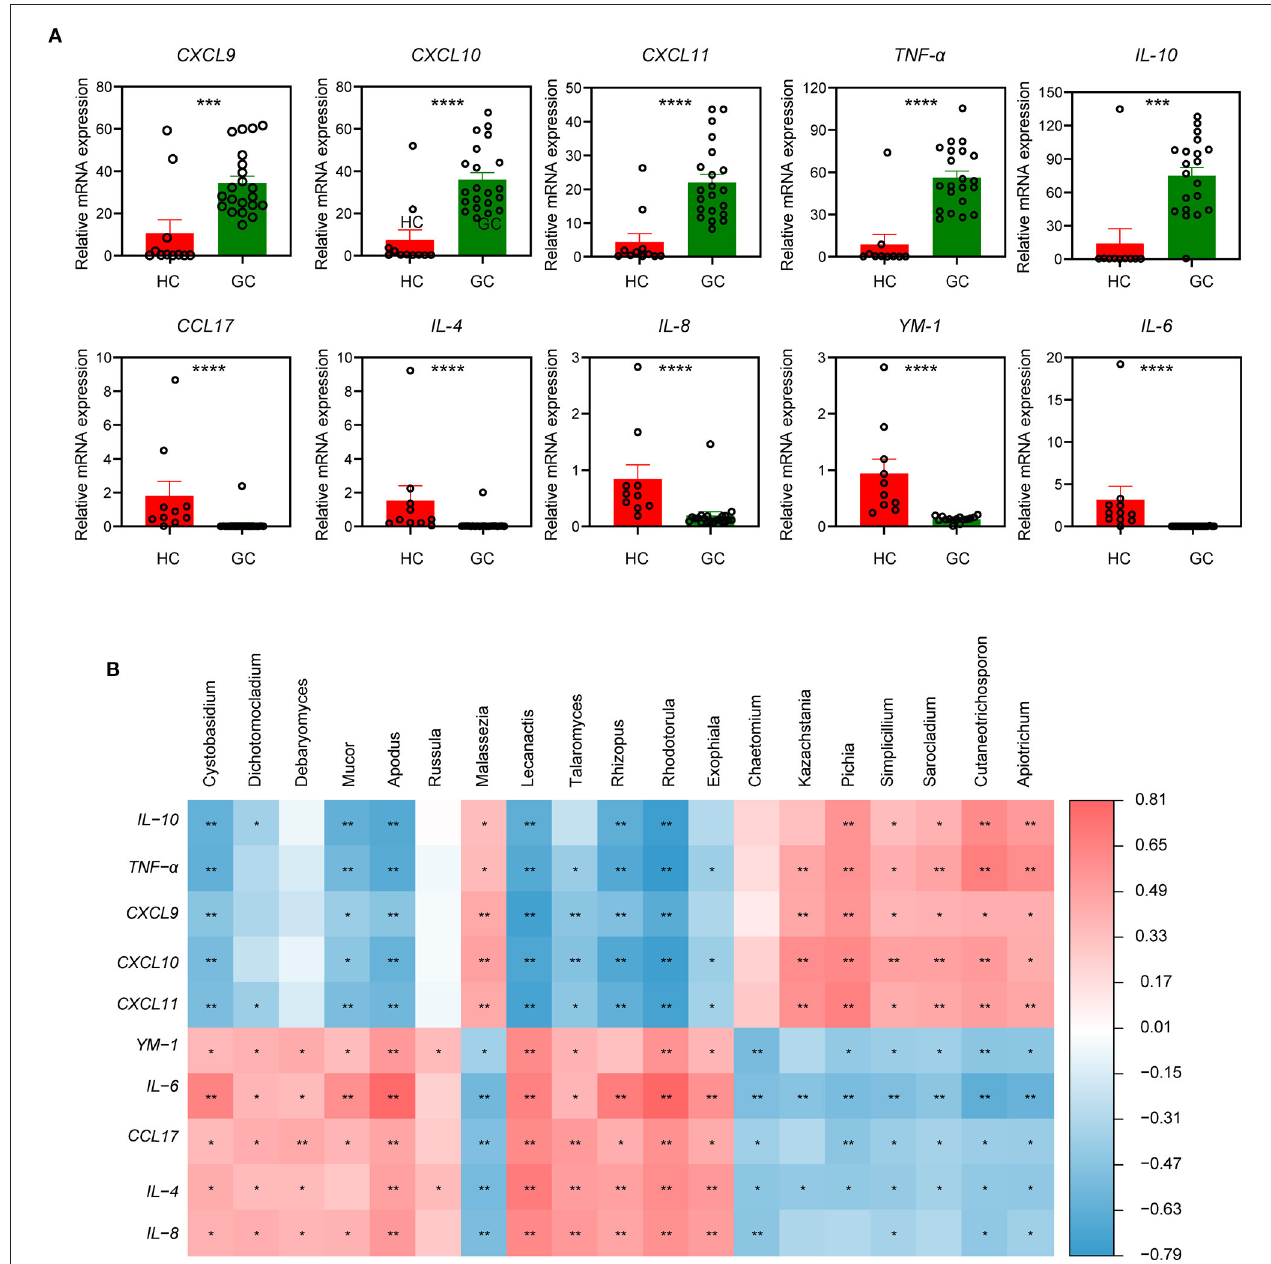
FIGURE 5 | The specific relationships of fungal genus and immune-related factors. (A) The relative tissue mRNA level of 10 immune cytokines in HC and GC groups. The differences are calculated by Mann-Whitney U test (*** p < 0.001; **** p < 0.0001). (B) Correlation analysis of the top 20 differential genera and 10 immune-related factors between the two groups according to the Spearman’s correlation analysis. The correlation effect is indicated by a color gradient from blue (negative correlation) to red (positive correlation). Correlation coefficients and p -values (* p < 0.05; ** p < 0.01) are